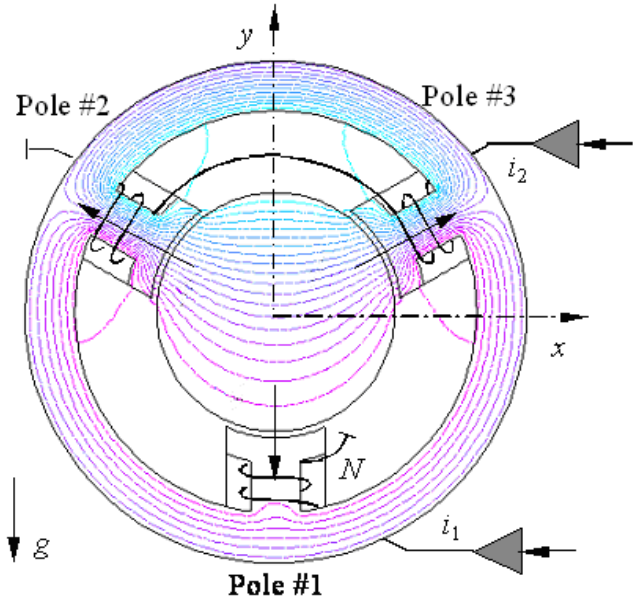
Figure 1. The 3-pole AMB system.